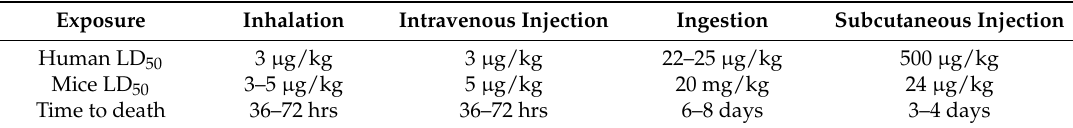
Table 2. Lethality of ricin (based on